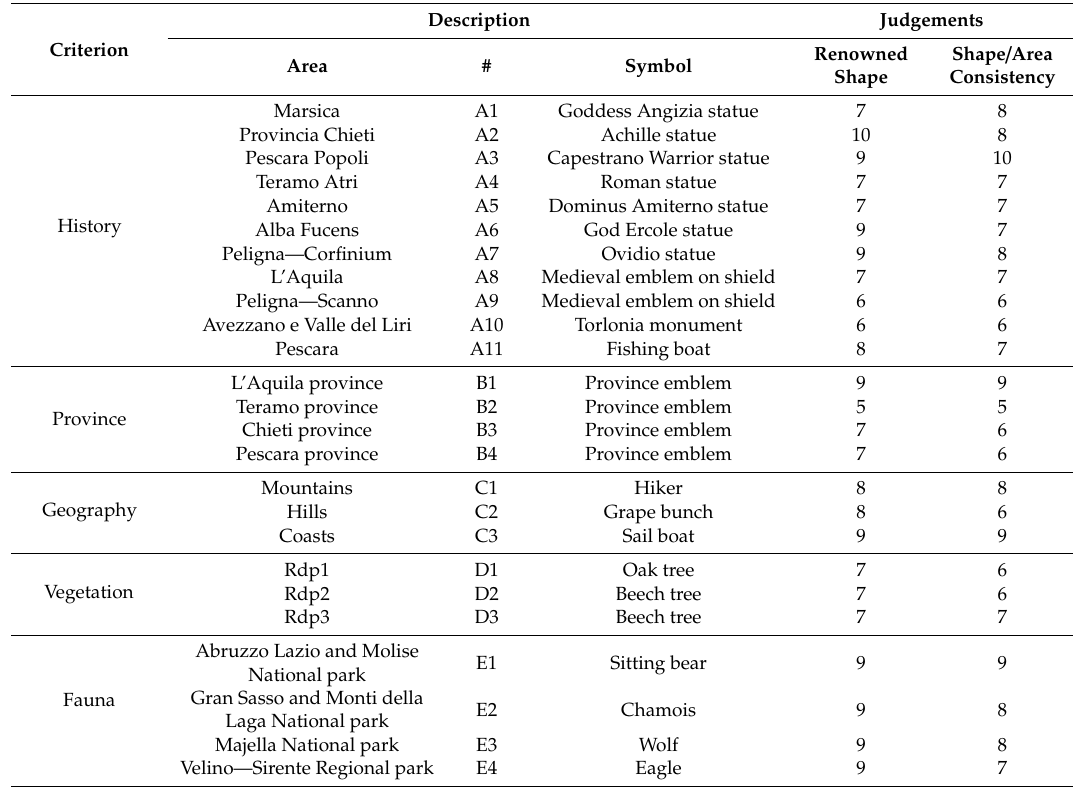
Table 2. Criteria for the subdivision in